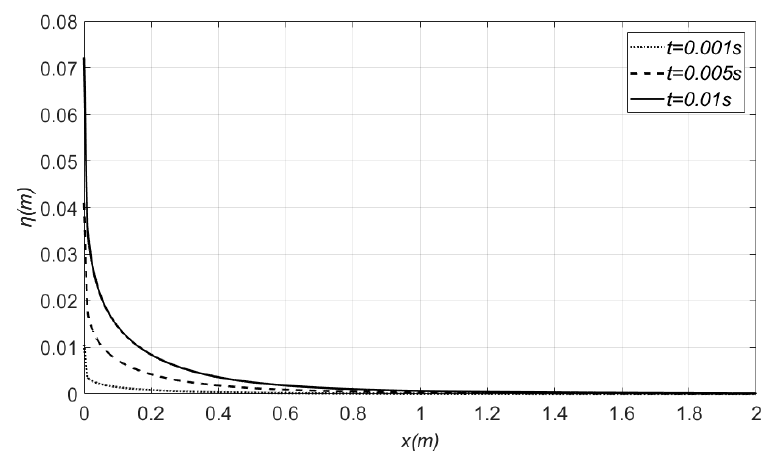
Figure 9. Free-surface elevations on the wall for di ff erent time instants, normalized wave impact velocity (cid:1874) = 300 and fixed air cavity position −1 ≤ (cid:1878) (cid:3030)(cid:3028)(cid:3049)(cid:3036)(cid:3047)(cid:3052) ≤ −0.5 .